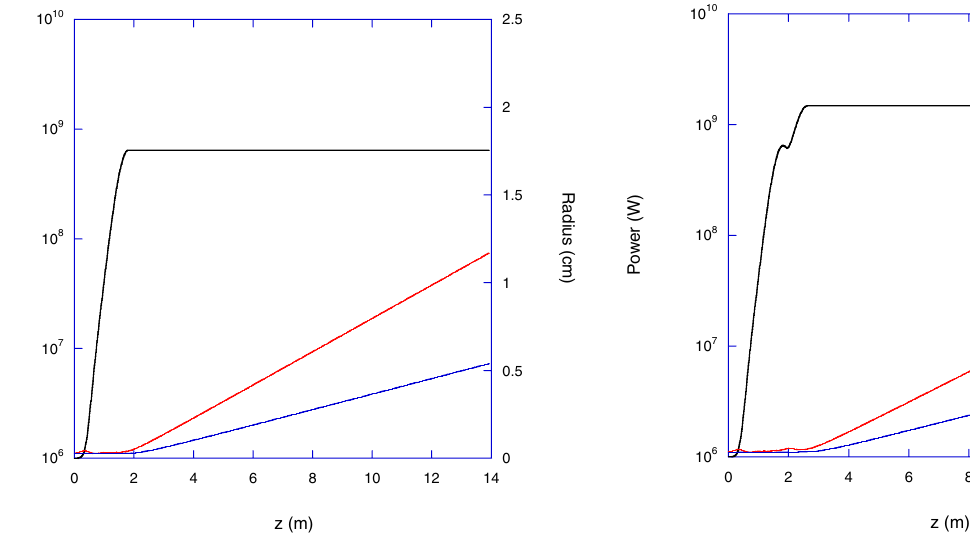
FIG. 5. (Color) Power (black), optical beam radius (red), and electron beam radius (blue) over a large distance for a matched- beam FEL with a uniform wiggler.